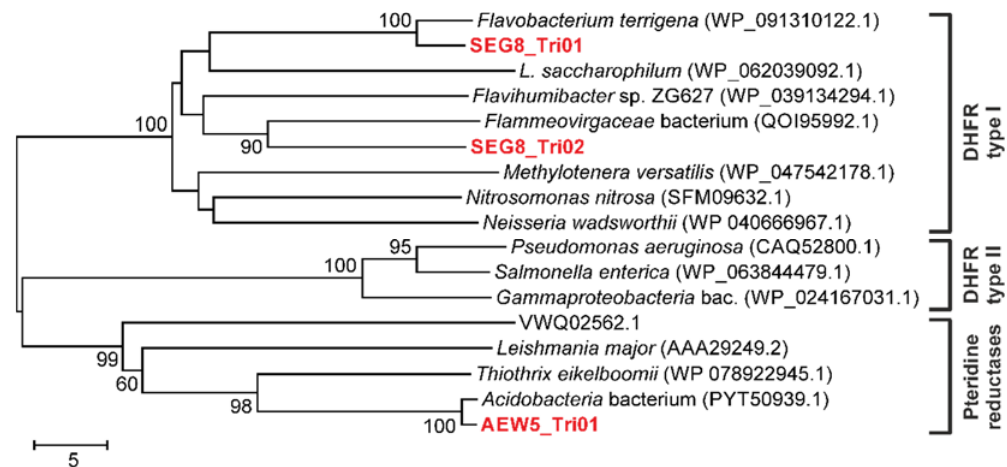
Figure 1. Neighbor-joining phylogenetic tree based on amino acid sequences of AEW5_Tri01, SEG8_Tri01, SEG8_Tri02, and different type I as well as type II dihydrofolate reductases (DHFRs) and pteridine reductases. Bootstrap values ≥ 50, based on 1000 iterations, are shown at branching points. Branches are annotated with the identified taxon names and accession numbers of the different proteins are given in parentheses. Abbreviations: L. saccharophilum , Lentimicrobium saccharophilum ; bac., bacterium.